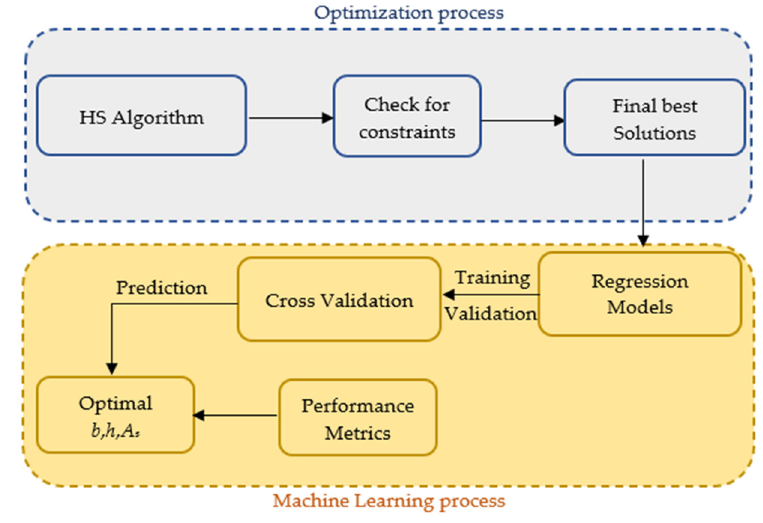
Figure 2. Flowchart of the proposed method for optimization and prediction.